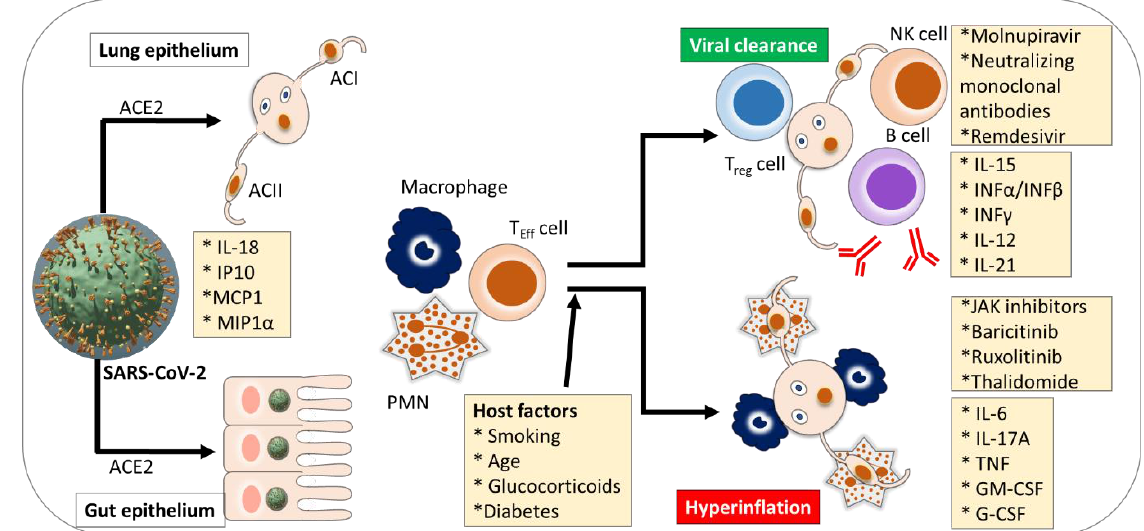
Figure 2. Cytokine pathogenesis of SARS-CoV-2 infection. Intensive care or appropriate treatment is recommended for hospitalized severe SARS-CoV-2 patients who exhibit elevated levels of biomarkers in blood plasma. Alveolar cell (AC), angiotensin-converting enzyme 2 (ACE2), atopic dermatitis (AD), ancestry clusters (AC1-4) granulocyte-macrophage colony-stimulating factor (GM-CSF), granulocyte colony-stimulating factor (G-CSF or GCSF), interleukin (IL), interferon (INF), monocyte chemoattractant protein 1 (MCP1), macrophage inflammatory proteins (MIP1α), natural killer (NK), polymorphonuclear granulocyte (PMN), T-effector cell (TEFF cell), tumor necrosis factor (TNF), regulatory T cell (T reg cell). Adapted and modified from